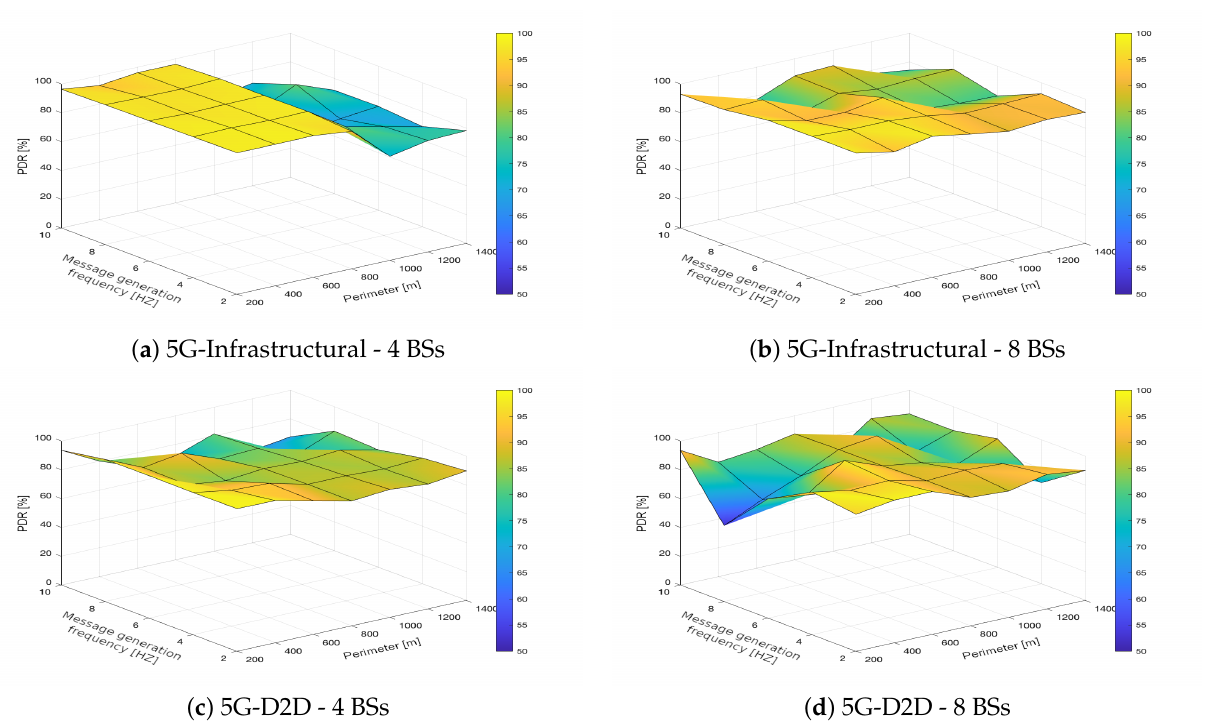
Figure 17. PDR simulated for the both modes of the 5G-based C-V2X technology, both infrastructure density deployments and traffic intensity of 1500 vehicles per